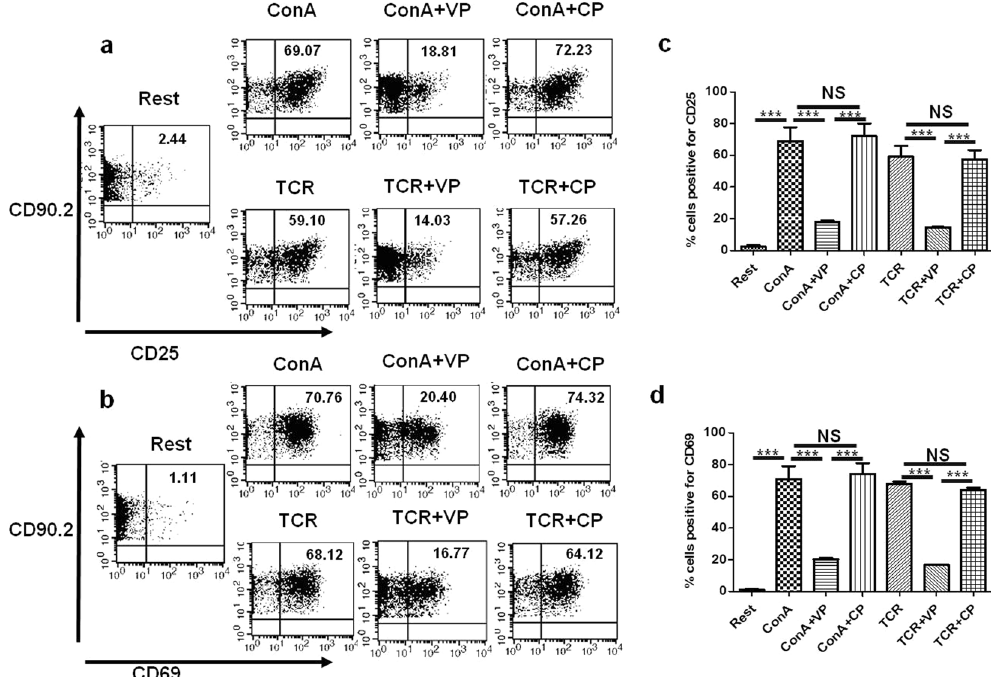
Figure 3. VIPER suppress the expression of T cell activation markers during T cell activation. ( a ) Flow cytometry dot plot showing CD25 surface expression (% positive cells) is significantly reduced in VIPER treated cells during ConA or TCR mediated T cell activation. ( b ) Similarly, the CD69 expression is also decreased in VIPER treated cells in comparison with cells activated only with ConA or TCR. ( c , d ) Bar graphs showing % positive cells expressing CD25 and CD69 respectively from three independent similar experiments Data shown are representative of three independent experiments and Bars represent the mean ± SEM. * p < 0.05, ** p < 0.01, *** p <